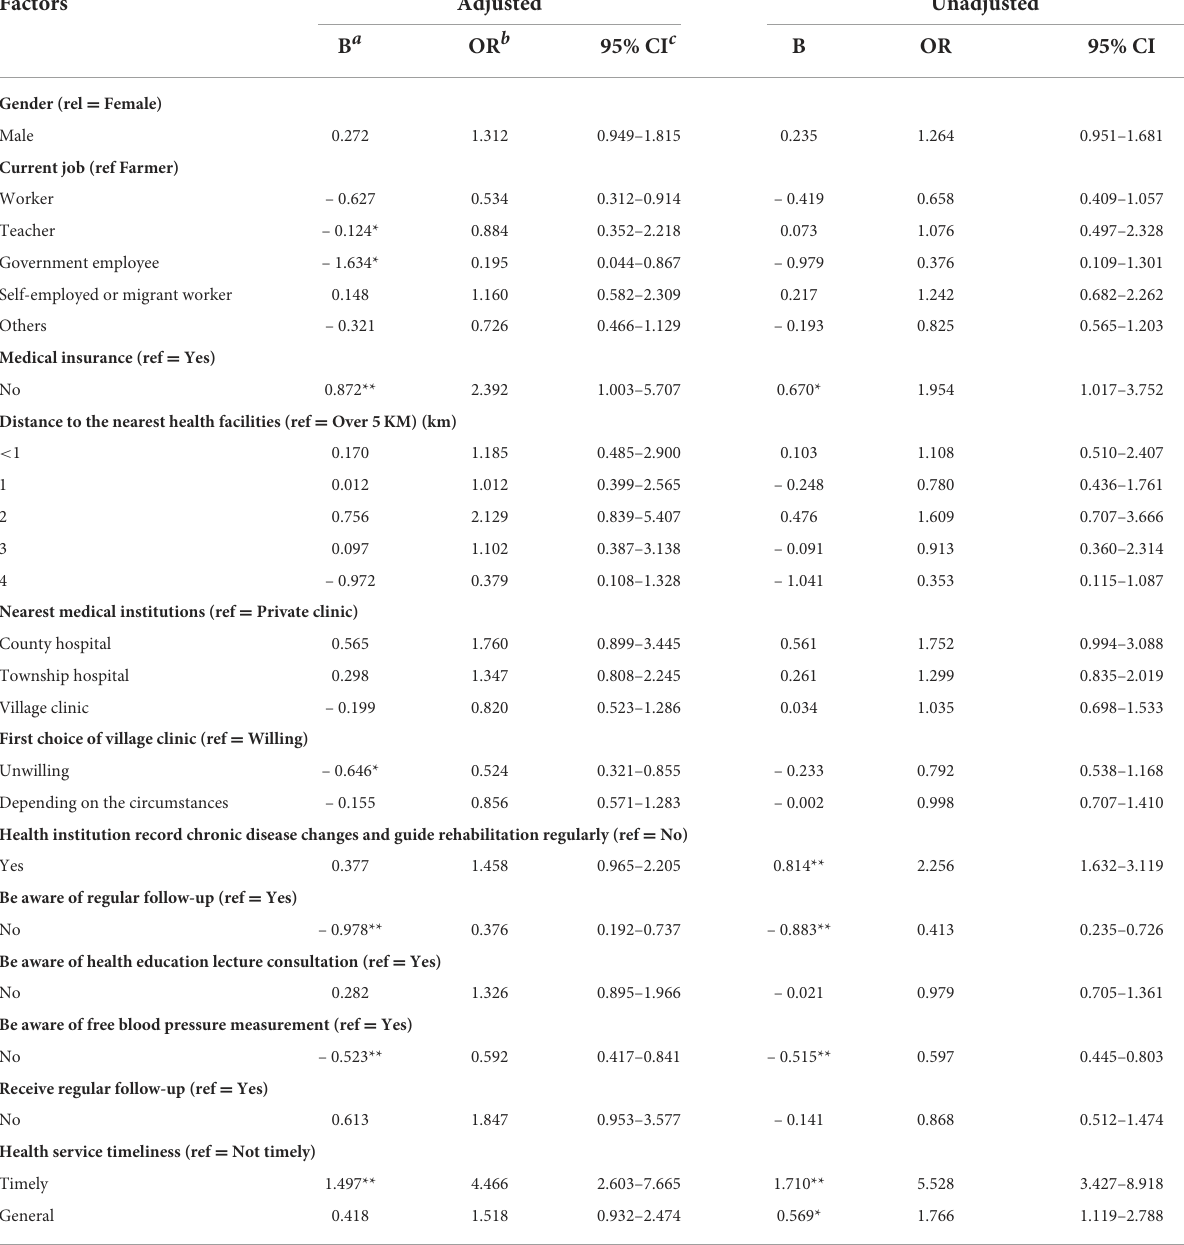
TABLE 3 Factors associated with patient satisfaction regarding chronic disease